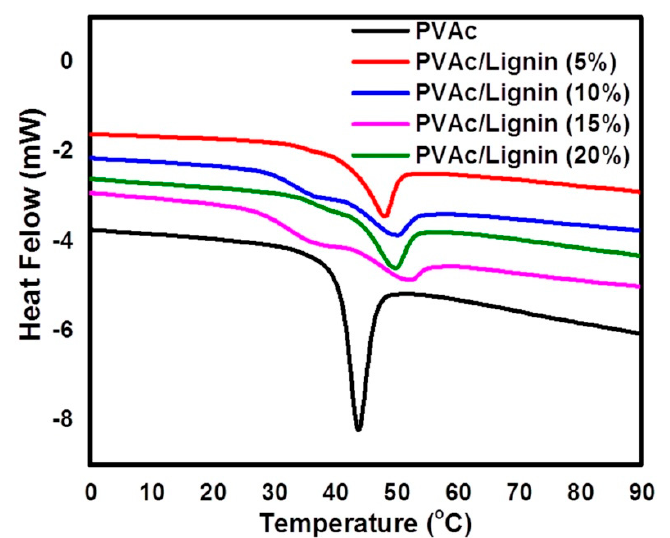
Figure 8. Differential scanning calorimetry (DSC) of papers coated with PVAc and its lignin copol- ymers containing different fractions of lignin.